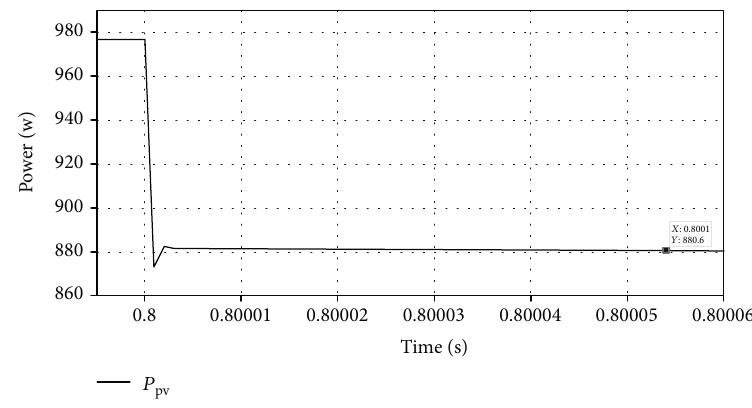
Figure 16: Zoom area of the PV array power.